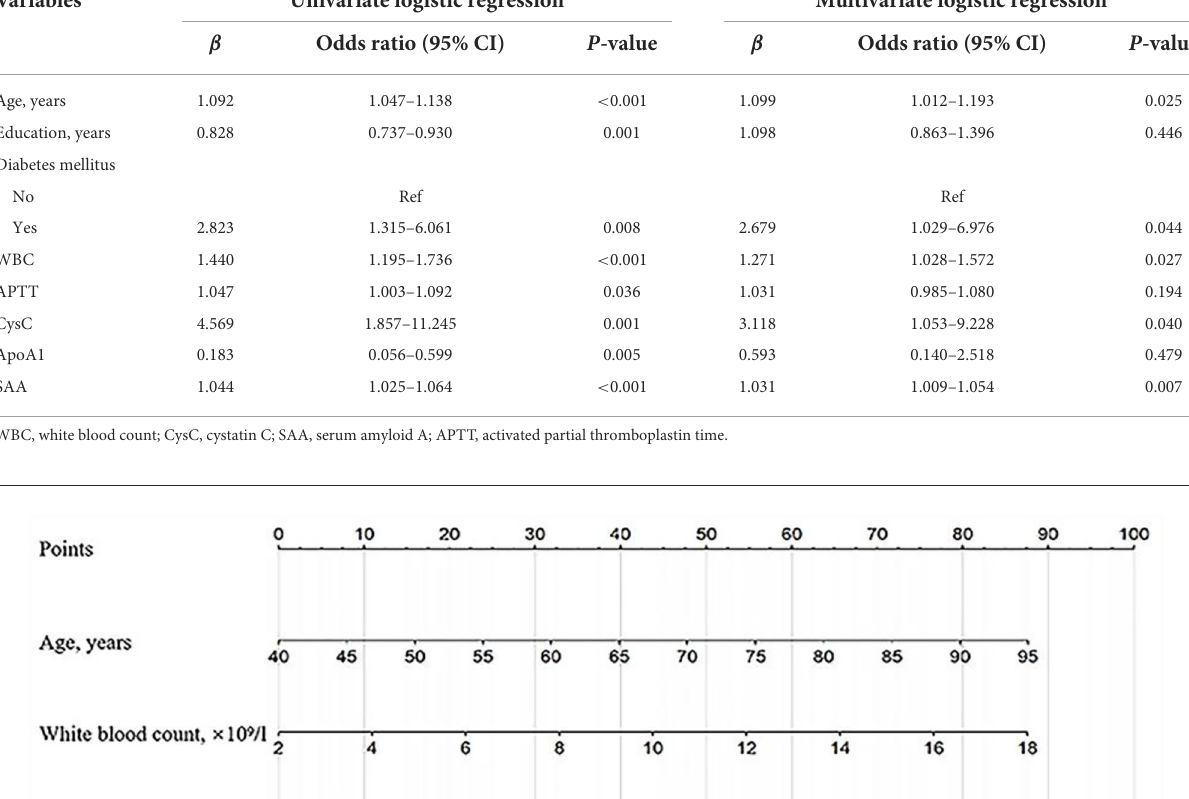
TABLE 3 Univariate and multivariate logistic regression analyses of risk factors for PSCI in the training set. Variables Univariate logistic regression Multivariate logistic regression